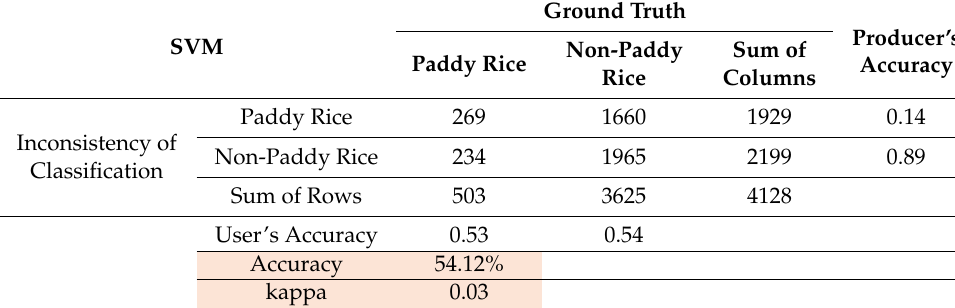
Table 5. Inconsistency of classification